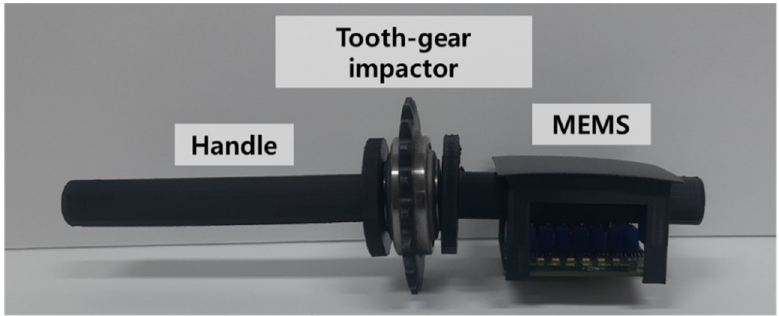
Figure 3. Photo of the contact mechanism: ( a ) 12 mm ball hammer, ( b ) 11-tooth gear.